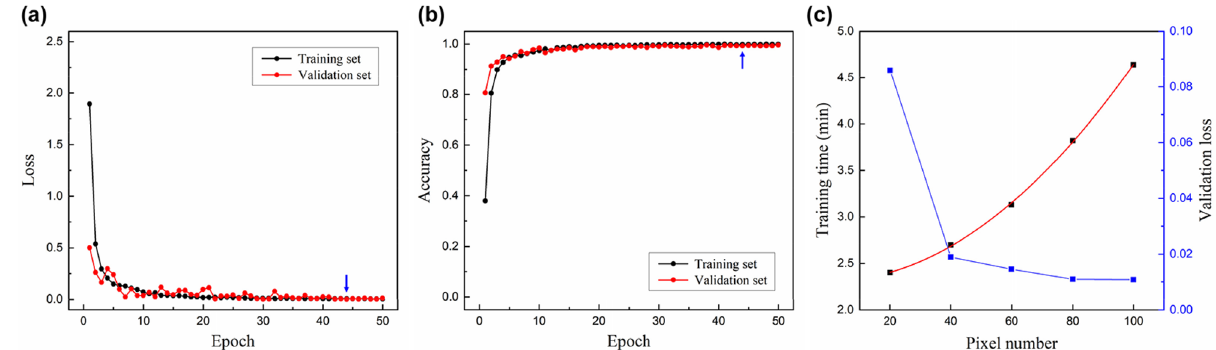
Figure 4. Training of the ATANN. ( a ) Loss and ( b ) accuracy curves for a training set and a validation set 2 1 × 10 − 14 m − 2 / 3 and (cid:31) l = 0.20 ). ( c ) Model evaluation for the input pixel size. Blue arrows indicate ( C n = 44th epoch at which minimum validation loss was achieved. Each data displayed in ( c ) is the result of a data set 2 1 × 10 − 14 m − 2 / 3 and (cid:31) l = 0.15 ) and shows the mean value of 15 training results. The red curve in (c) ( C n = represents a fitting